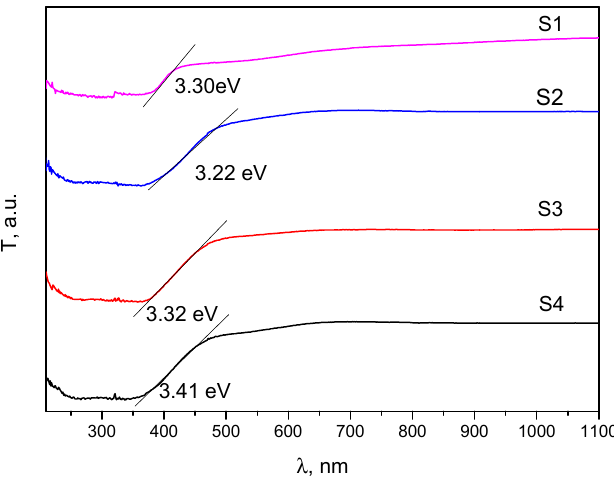
Figure 4. The optical absorption energy band gap estimated for CeO 2 /ZnO samples.